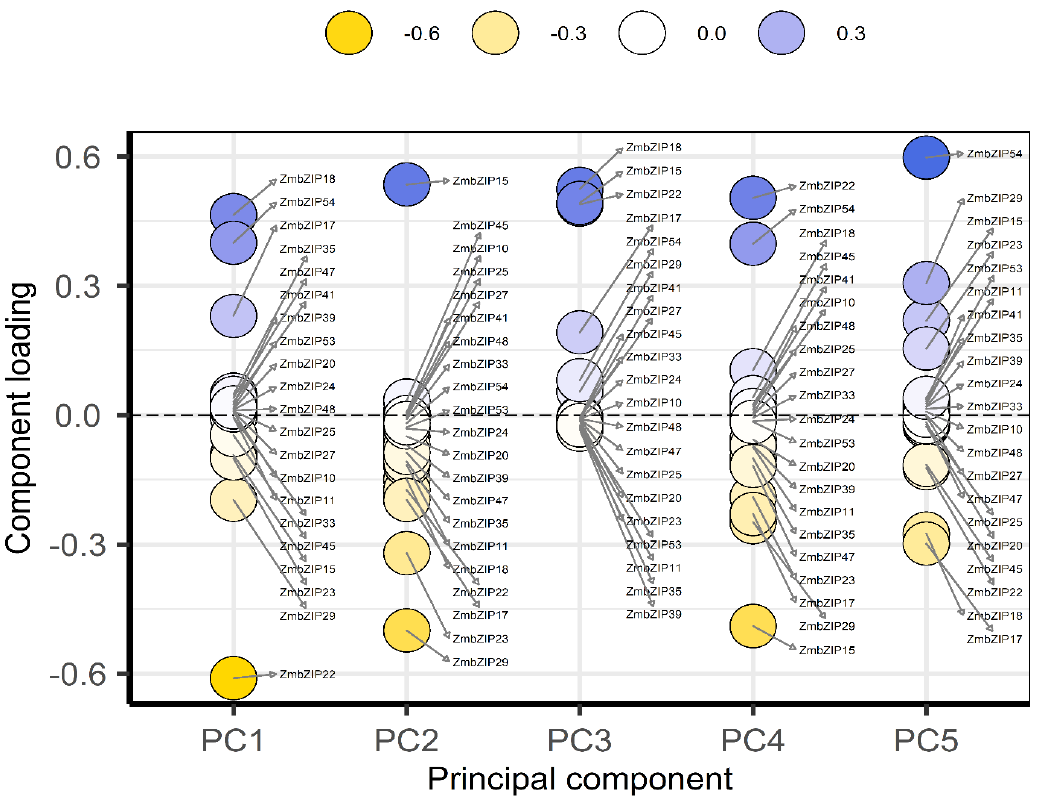
Figure 8. The principal component analysis (PCA) of these 54 ZmbZIP genes. The Pearson values of these 54 genes were used for principal component analysis (PCA). The Vertical axis represents the loadings and the horizontal axis represents the divided PCA component. The greater the absolute value of the loadings, the greater the proportion of genes in the principal component.